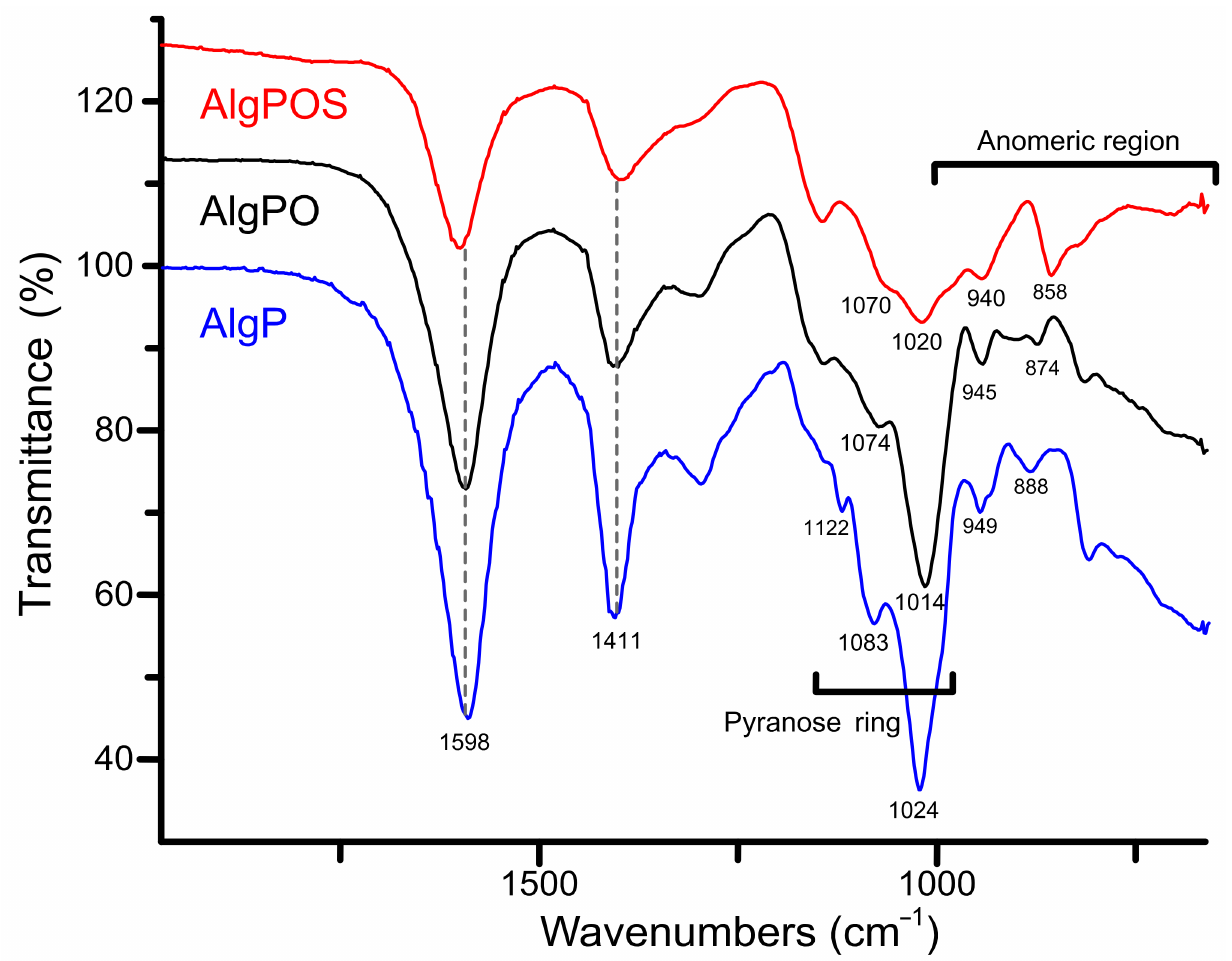
Figure 6. ATR-IR spectra of the starting material (AlgP), oxidized alginate (AlgPO) and alginate-based material